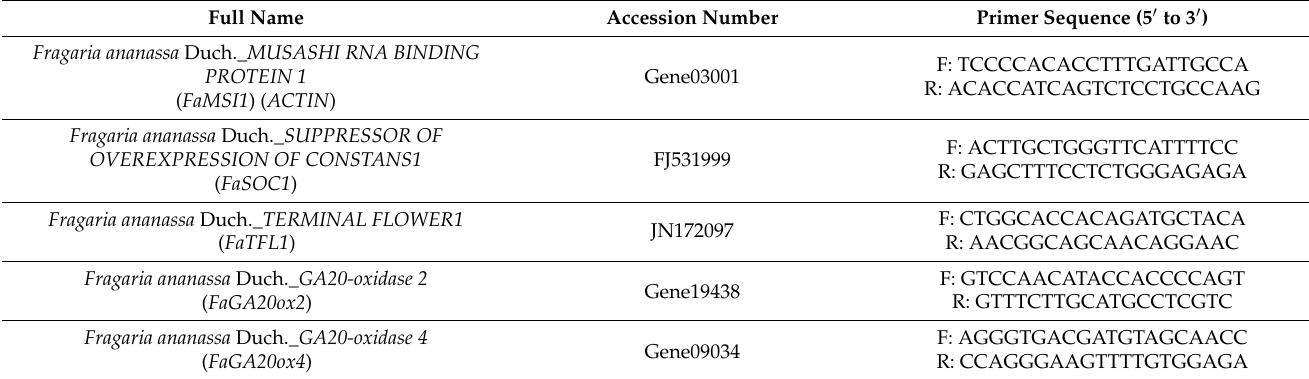
Table 1. List of the primers used to quantify the gene expression